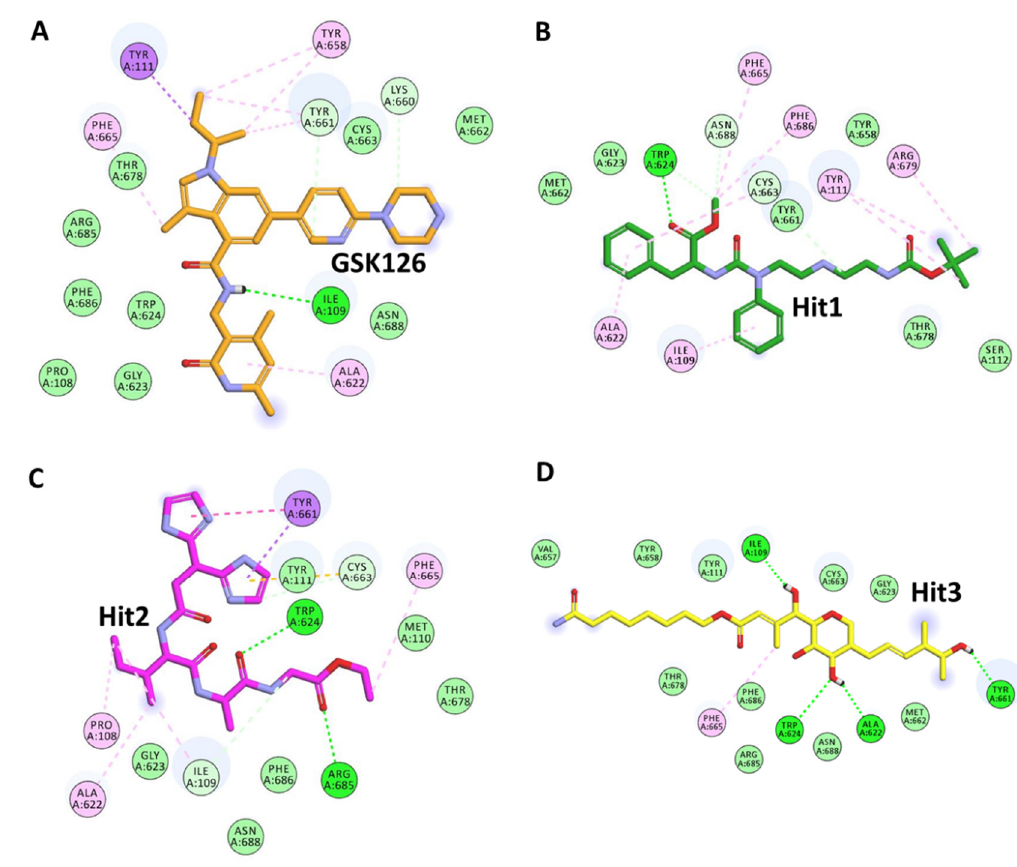
Figure 10. Two-dimensional schematic representations of protein–ligand interactions between GSK126 (reference compound) and the top three hits: ( A ) GSK126, ( B ) Hit1 (NCI694864), ( C ) Hit2 (NCI670557) and ( D ) Hit3(NCI706726). The hydrogen bonds, Л - Л , Л -cation, and Л -Sulphur are shown as green, pink and purple dashed lines, respectively. Table 4. List of selected hits from NCI library.